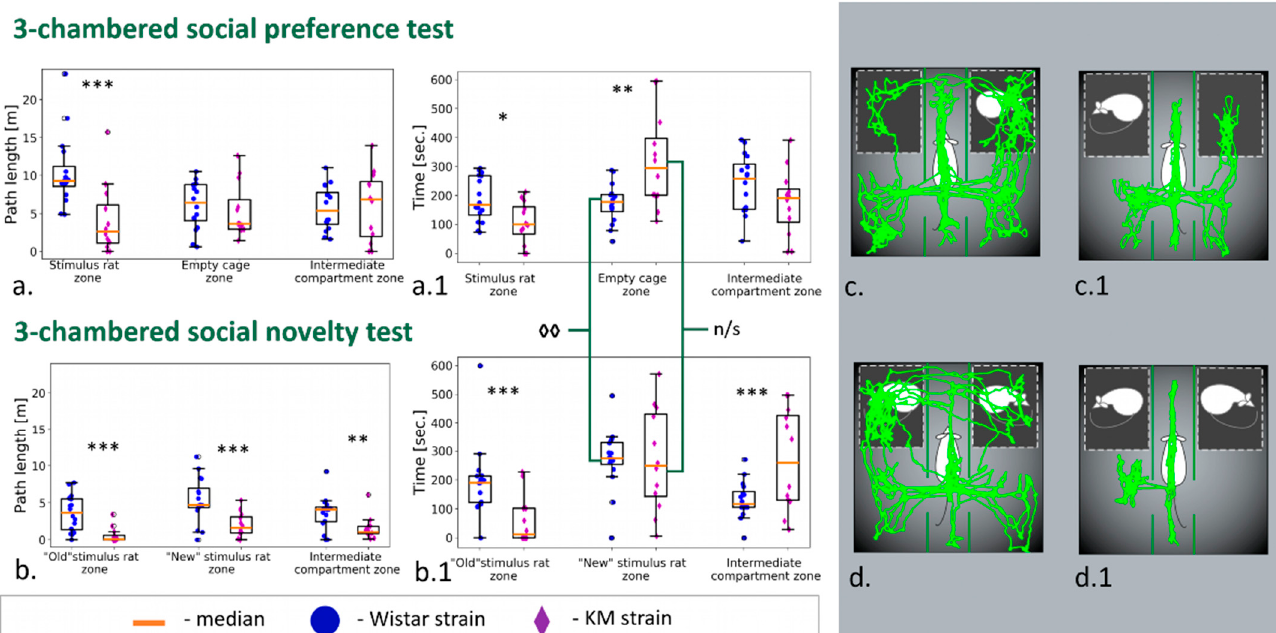
Figure 3. Locomotion activity in social tests: path lengths ( a ) and the zone times ( a.1 ) in three-cham- bered social preference test; in social novelty test ( b , b.1 ); representative individual tracks of Wistar ( left ) and KM ( right ) rats in the three-chambered social preference test ( c , c.1 ), in the three-cham- bered social novelty test ( d , d.1 ). Wistar rats are shown as blue circles, KM as violet diamonds. KM rats demonstrated a significant decrease in the path travelled around the stimulus rat zone ( a ), to- gether with the corresponding time spent ( b ). The addition of the second conspecific (the three- chambered social novelty test) induced general hypolocomotion in KM rats ( b ). Remarkably, after the addition of the new social stimulus, Wistar (but not KM) rats significantly increased the corre- sponding chamber time (green brackets mark the within-group comparisons, ( a.1 , b.1 )). Data are represented as the box plot and whiskers (indicating variability outside the upper and lower quar- tiles). Between-group difference (Mann–Whitney U-test) is indicated as follows: *** p < 0.001, ** p < 0.01, * p < 0.05. Within-group difference (Wilcoxon matched pairs test) is indicated as ◊◊ for p < 0.01 .